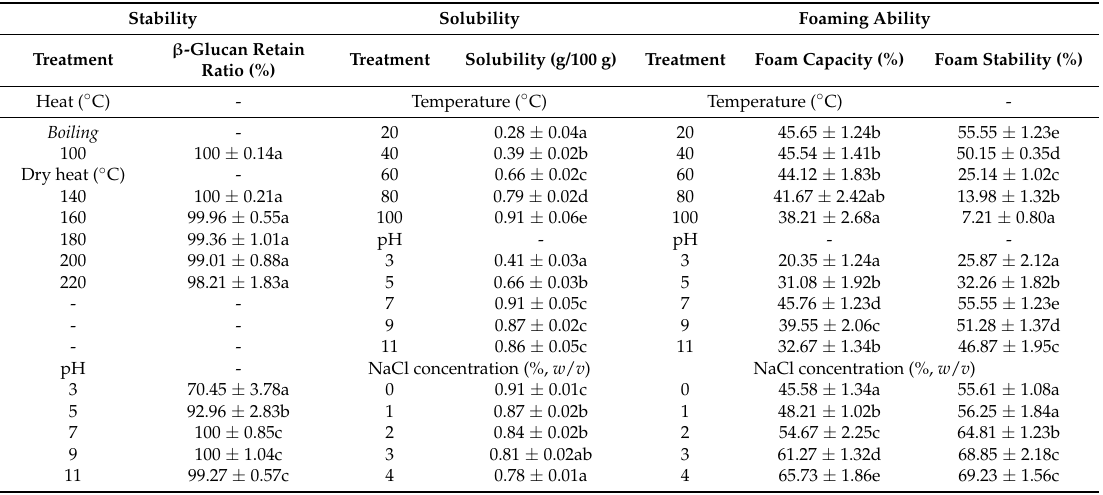
Table 1. Stability, solubility, and foaming ability of β -glucan extract (GE) from highland barley.